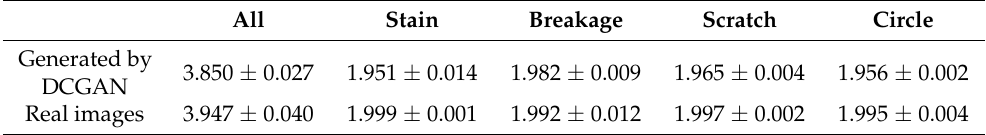
Table 5. Inception score of the real and generated images (IS ± std).